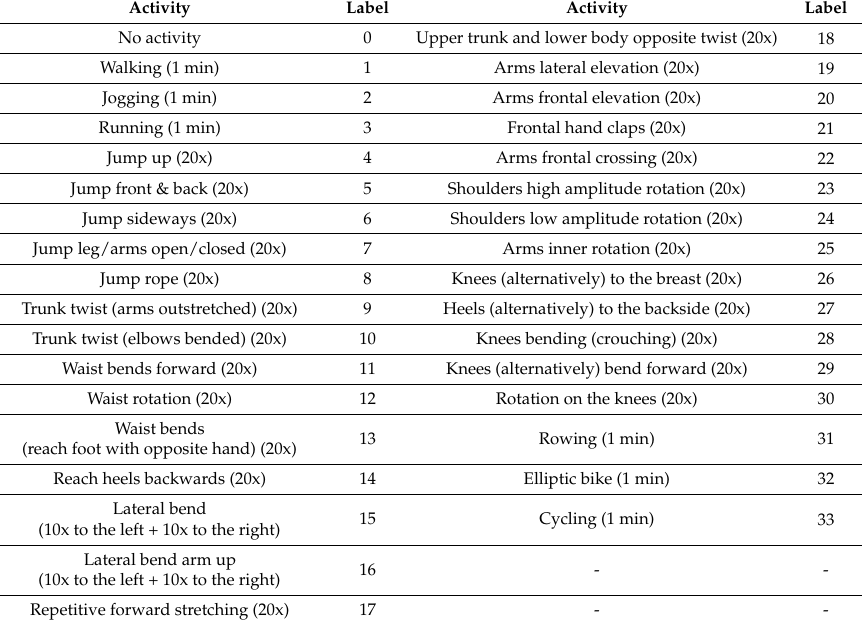
Table 1. Activity set in dataset 1.